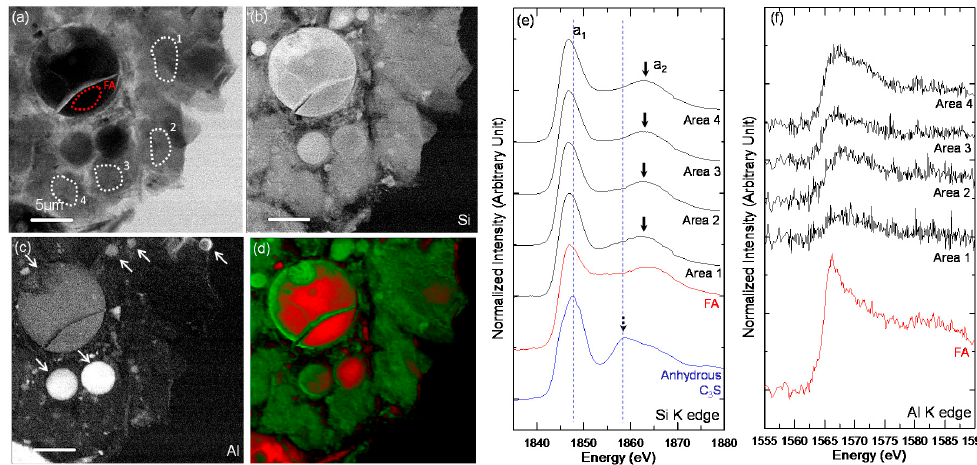
Figure 9. The STXM results of C-FA-28d (Figure 7c-2). ( a ) Single image taken at 1840 eV with marked areas for Si NEXAFS analysis (FA: fly ash); ( b ) Si image contrast map; ( c ) Al image contrast map; ( d ) RGB overlay maps obtained using the spectra from FA ( red ) and Area 2 ( green ); ( e ) Si K edge NEXAFS spectra; and ( f ) Al K edge NEXAFS spectra. The Si and Al K edge spectra were obtained from the ROIs illustrated in ( a ). Fly ash particles are indicated by the arrows in the Al image contrast map. All peak positions (a 1 and a 2 ) and energy separations (a 2 − a 1 ) of the selected areas of C-28 and